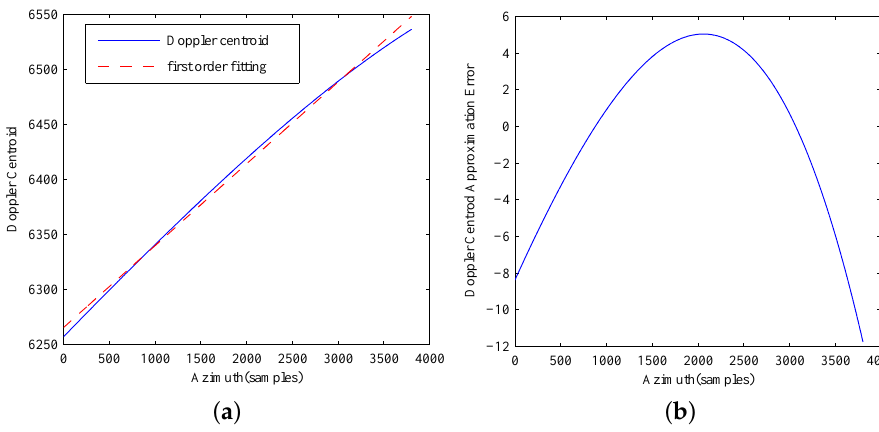
Figure 9. Diagrams of the first-order fitting of the Doppler centroid and its approximation error. ( a ) Doppler centroid and its fitting curve; ( b ) Doppler centroid approximation error.